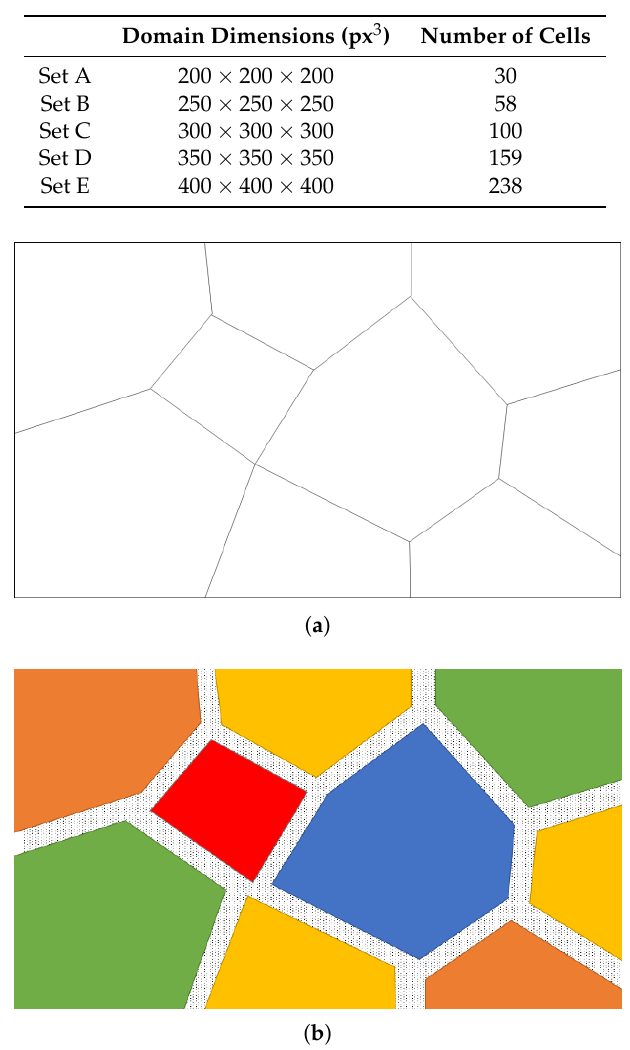
Table 1. Characterizations of each set of closed-cell structures.